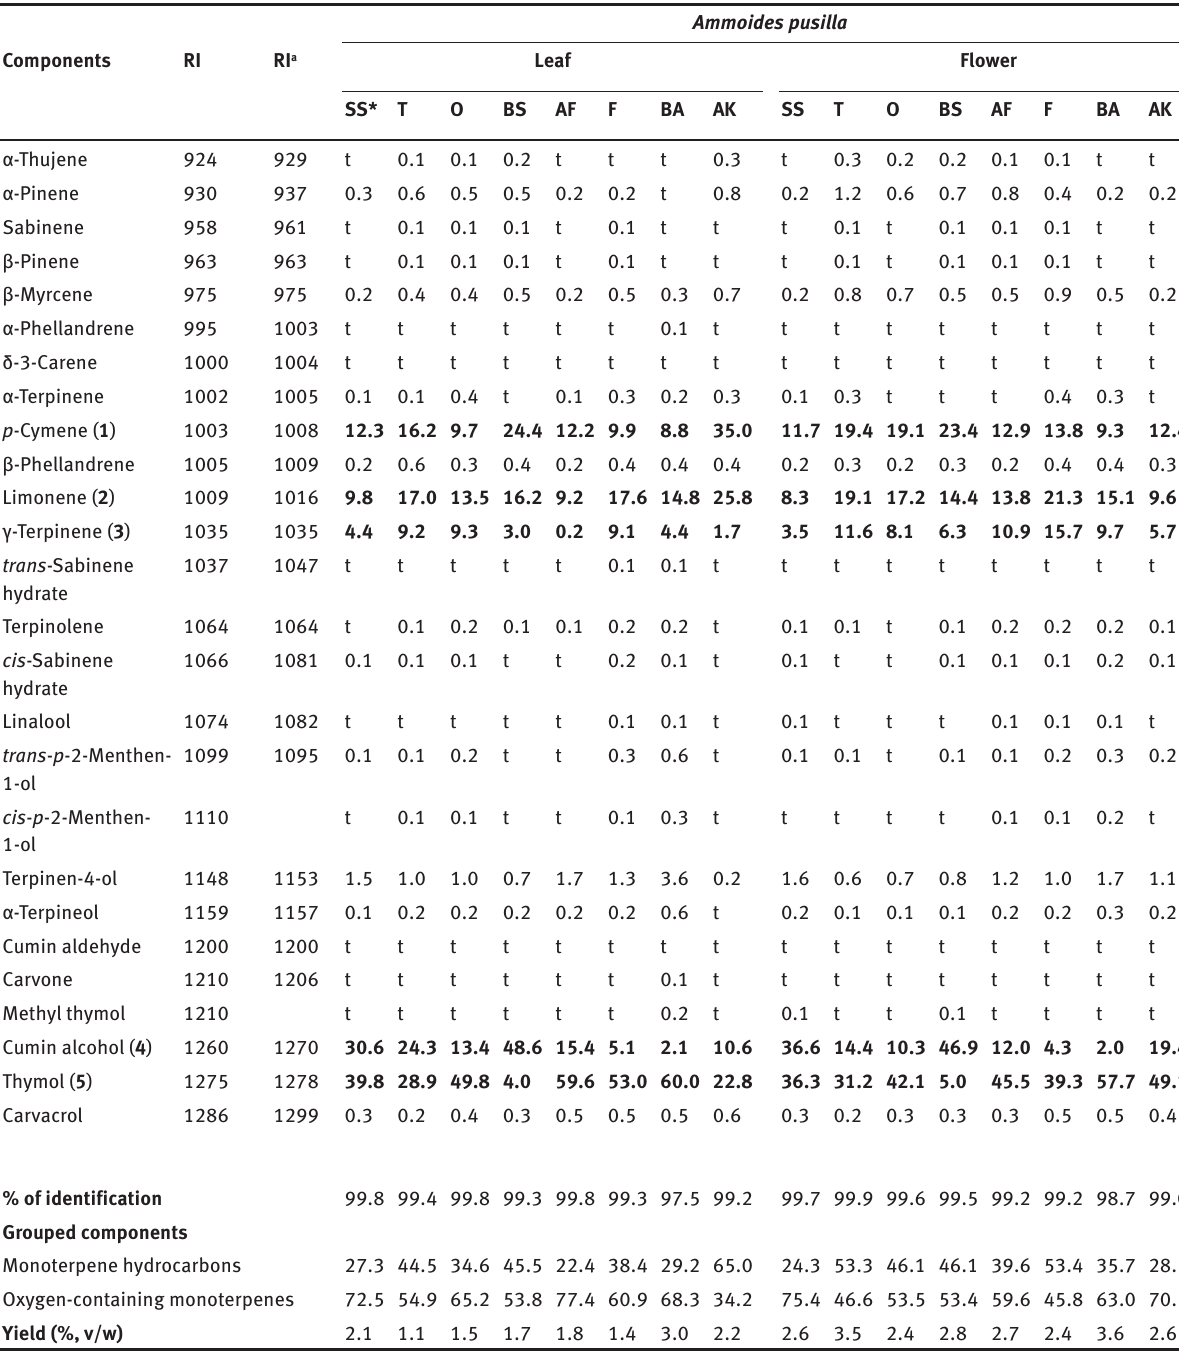
Table 2: Percentage composition of the essential oils isolated from the leaves and flowers of Ammoides pusilla populations from different collection sites in